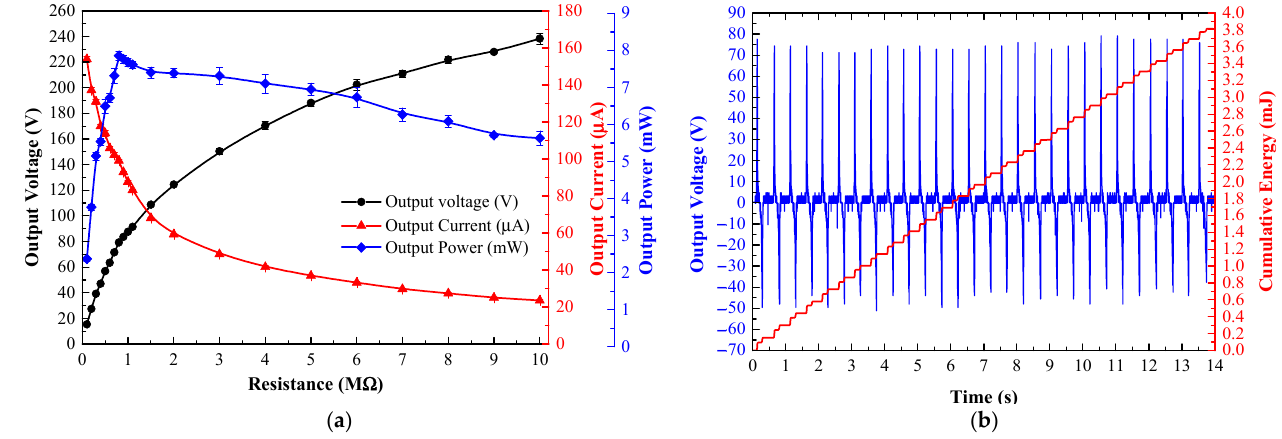
Figure 9. Electrical characteristics of TEHFT with the 0.1 mm PTFE film thickness: ( a ) output voltage, current, and power across resistive loads; and ( b ) graph of output voltage and accumulated energy across the optimal load.